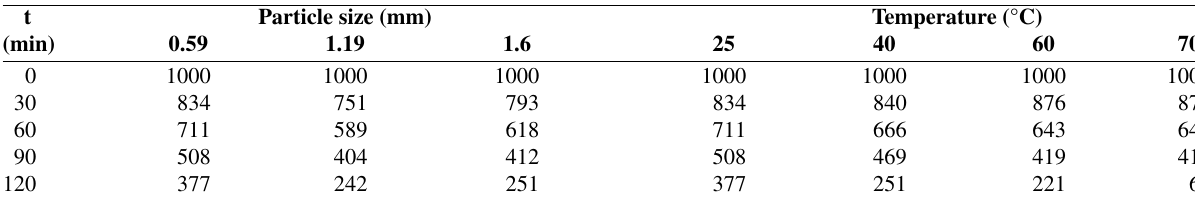
Table 3 . Manganese concentration (mg/L, in italics) remaining in solution, with respect to the particle size of activated carbon (mm), temperature (°C) and reaction time (min). t Particle size